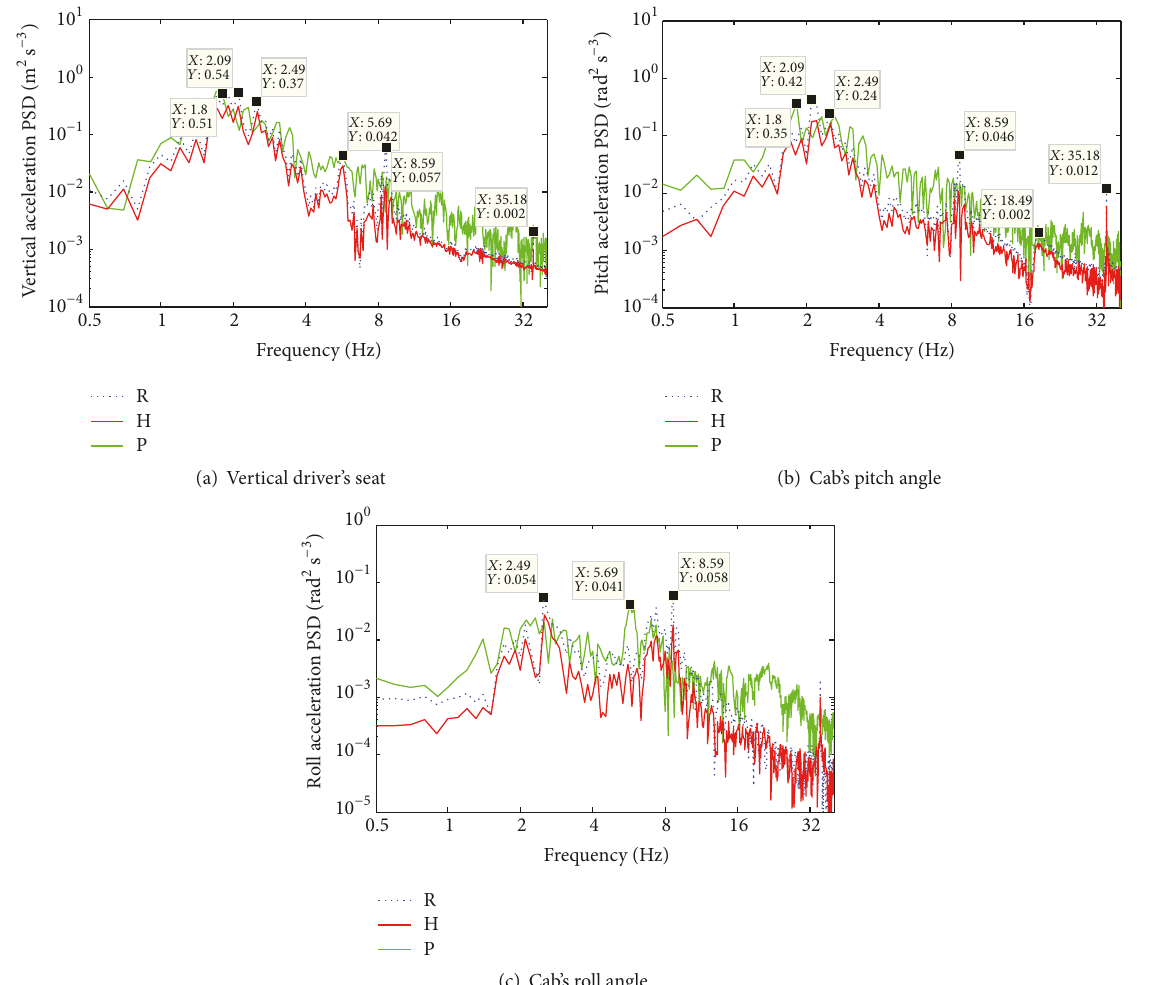
Figure 13: The acceleration PSD responses on a high-density soil ground at high excitation frequency 35 Hz of the drum.